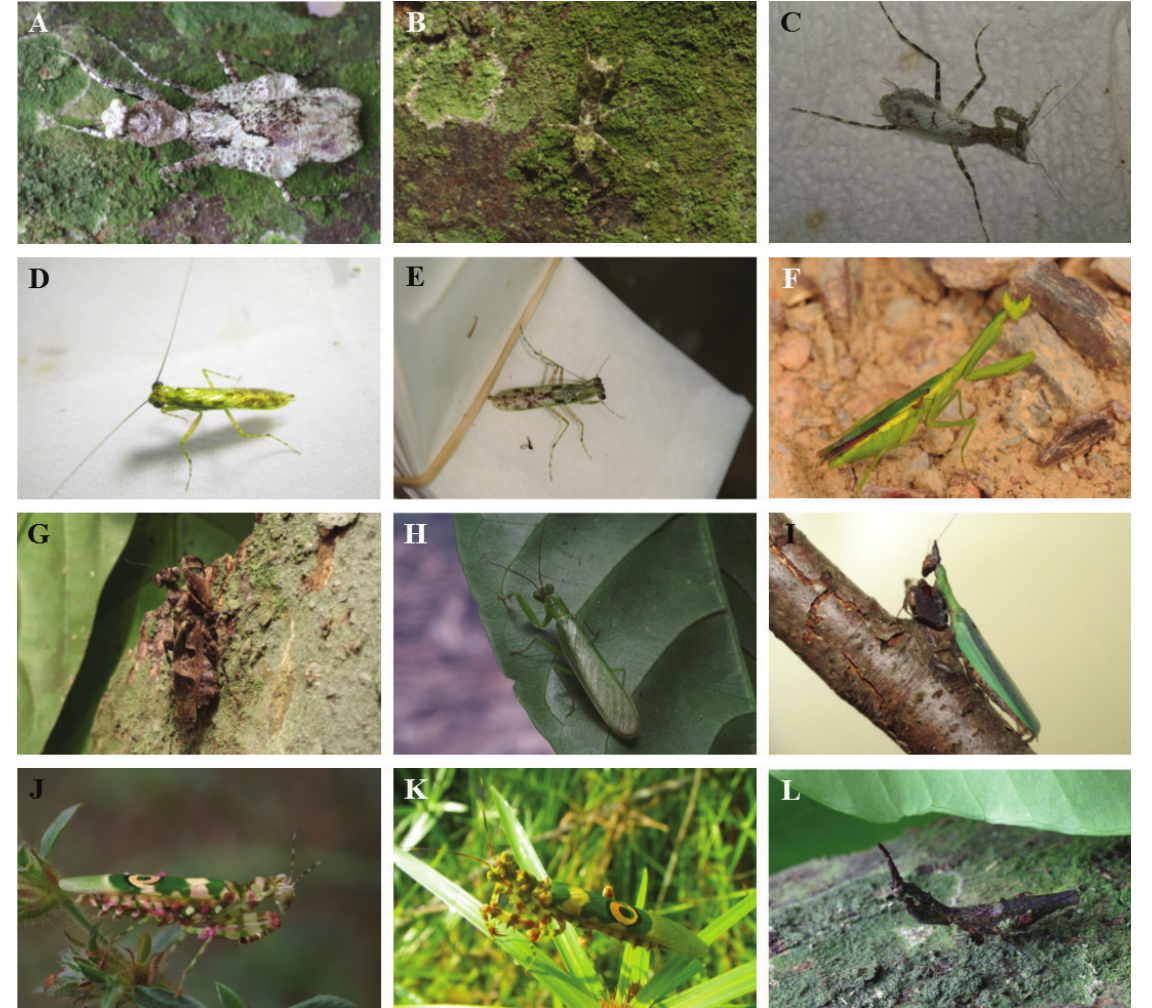
Fig. 4. Live habitus. A. Theopompella aurivillii (female) from DNNP; B. Theopompella sp. (young) from DNNP; C. Dactylopteryx flexuosa (female) from DNNP; D. Amorphoscelis griffinii (male) from DNNP; E. Amorphoscelis pulchra (male) from DNNP; F. Galinthias amoena (female) from LNP; G. Panurgica feae (female) from DNNP; H. Chloroharpax modesta (male) from DNNP; I. Anasigerpes bifasciata (fe- male) from DNNP; J. Pseudocreobotra ocellata (female) from LNP; K. Pseudocreobotra ocellata (male) from DNNP; L. Oxypiloidea ( Cata- sigerpes ) margarethae (female) from